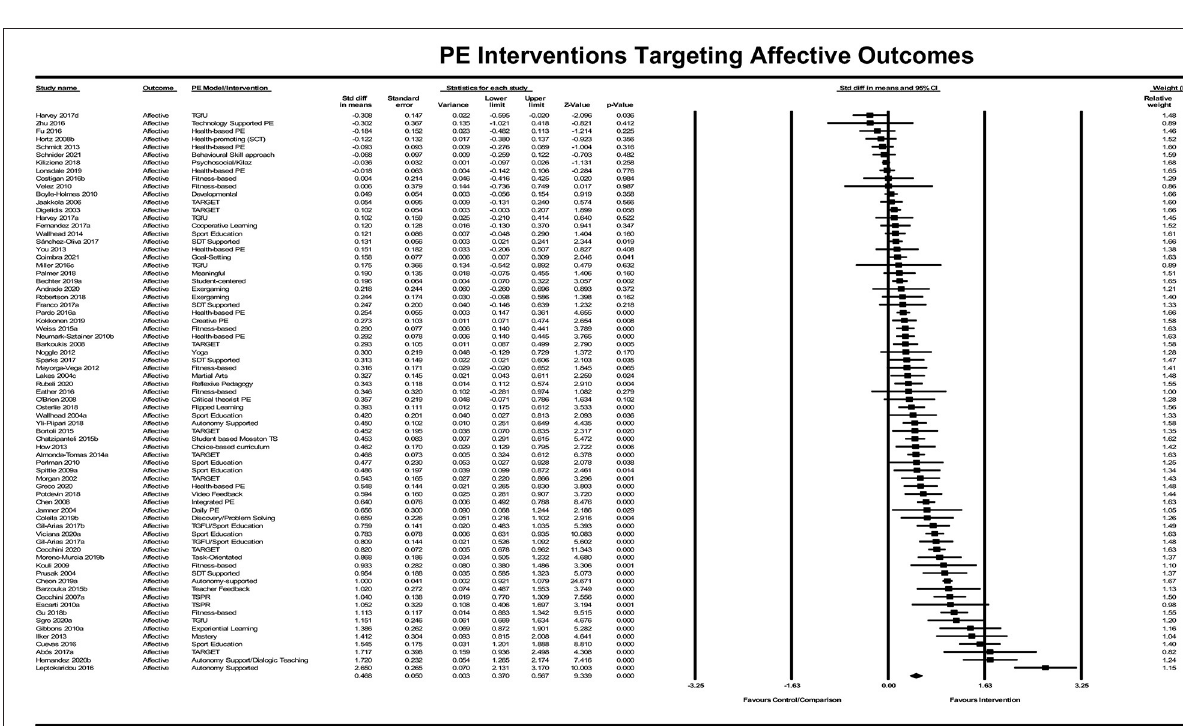
FIGURE 9 | Forrest plot of standardized difference in means of affective PE